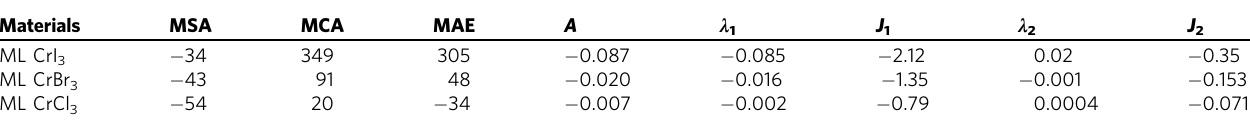
The energy and coupling strength are in μ eV and meV,